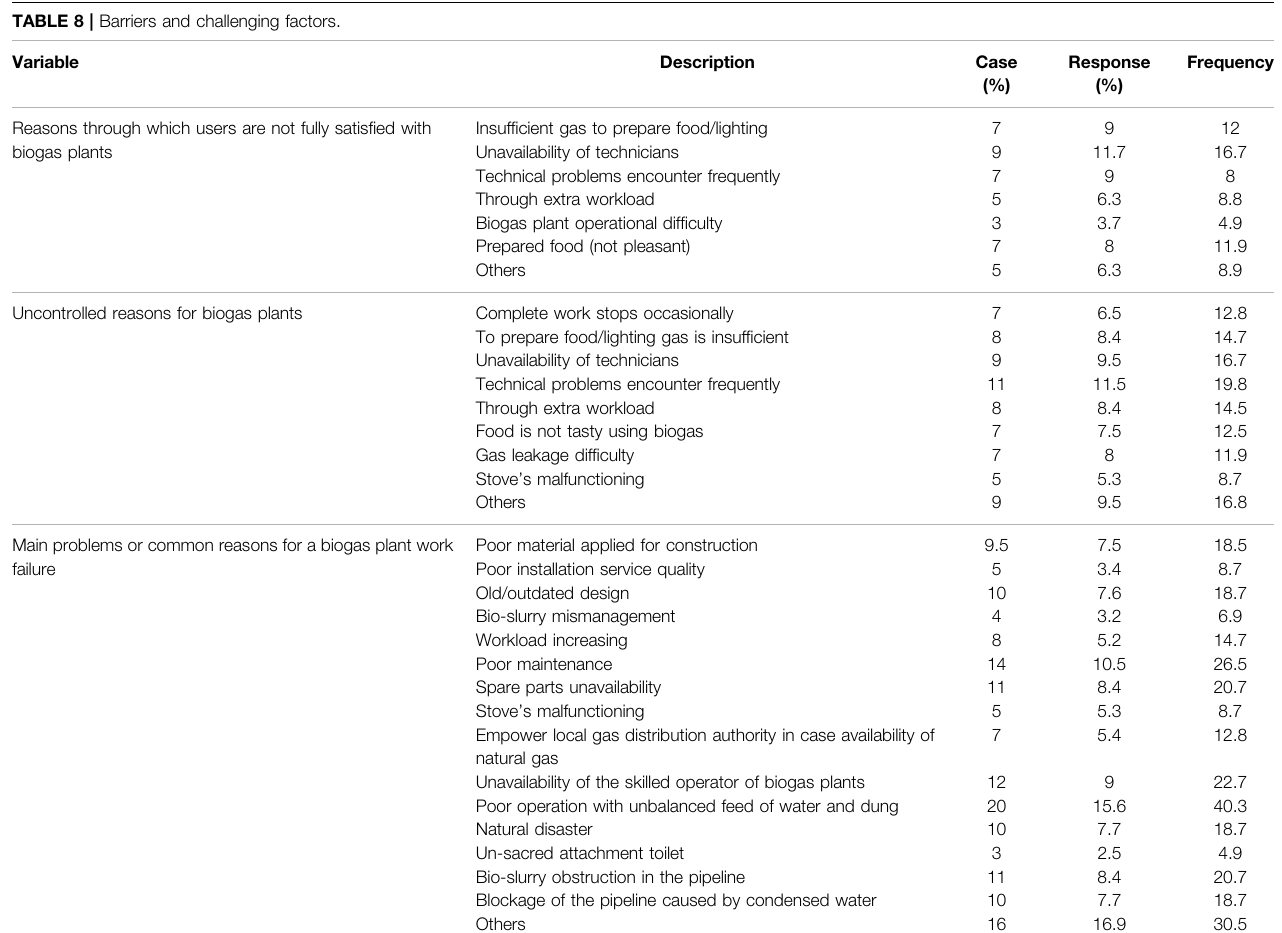
TABLE 8 | Barriers and challenging